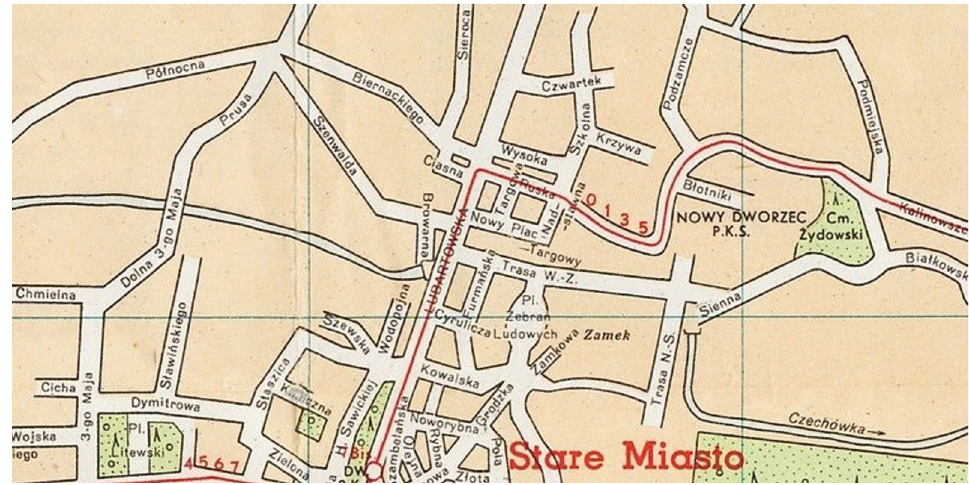
Fig. 9. Zebrań Ludowych Square in the place of the old route of Szeroka